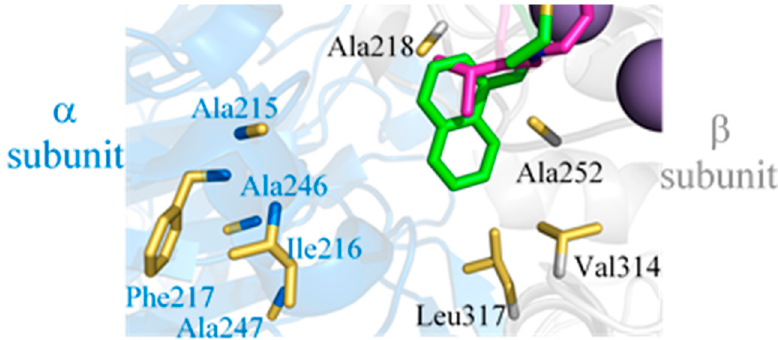
Figure 9. The hydrophobic amino acids ( D -Val (purple), D -Nal1 (3-(1-naphthyl)- D -alanine, green)) at X7 position of LXW-analogous cyclic octapeptides (cGRGDd X c-NH 2 ) binds at the major hydrophobic interface between the α (blue) and β (grey) subunits formed by Ala215, Ile216, Phe217, Ala246, Ala247 in the α subunit and Ala218, Ala252, Val314, Leu317 in the β subunit of the α v β 3 integrin.